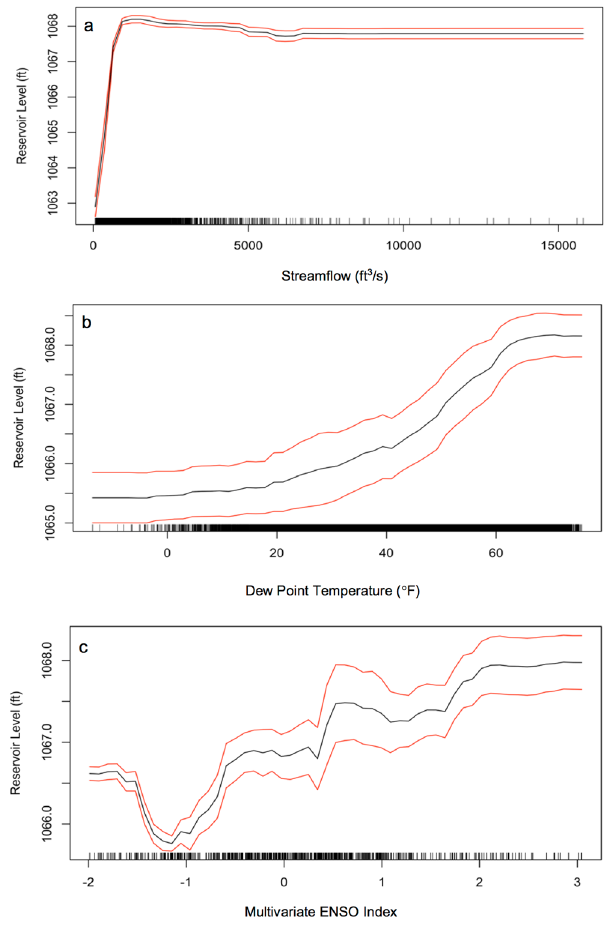
Figure 3. Partial dependency plots for the ( a ) streamflow into Lake Lanier, ( b ) dew point temperature, and ( c ) multivariate ENSO index, each with a 95% confidence band and data distribution notches along the